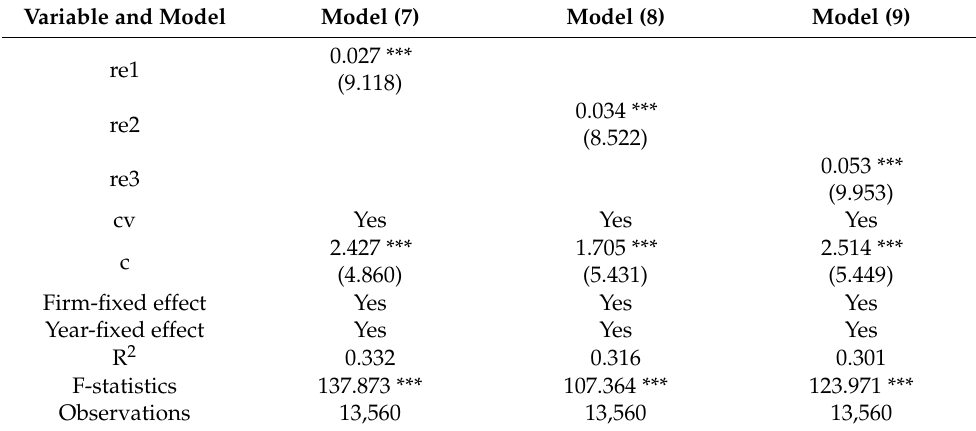
Table 5. Results of robustness